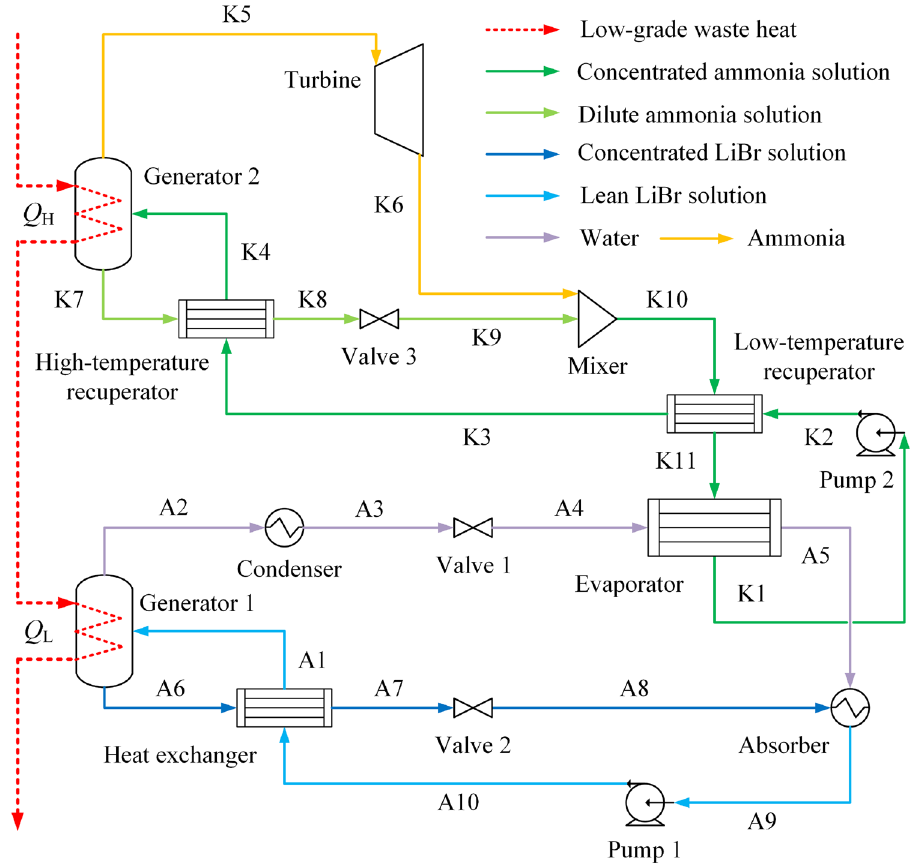
Fig. 1 Schematic diagram of the coupled